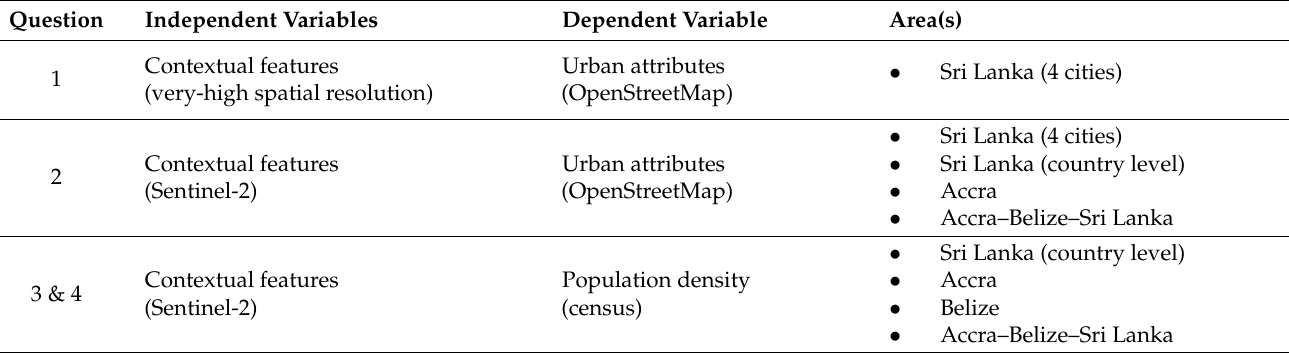
Table 1. Contextual feature relationships to urban attributes and population density analyzed in research.